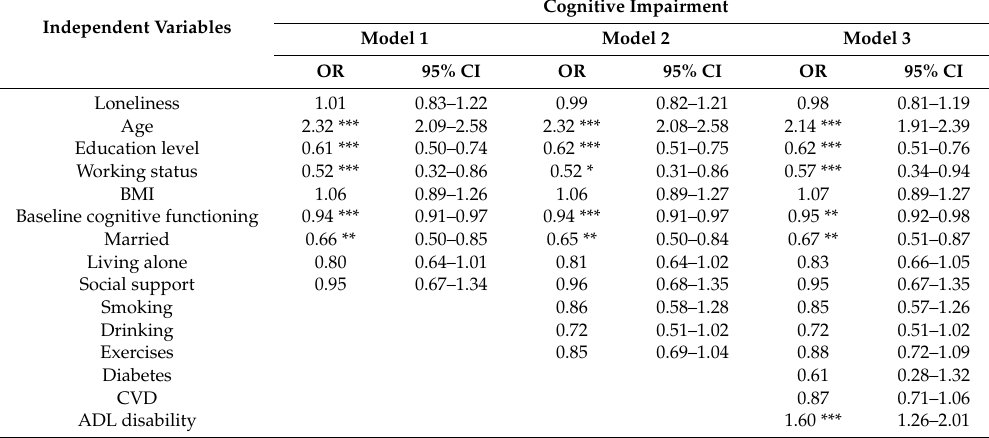
Table 3. Association between loneliness and cognitive impairment among women aged 65 or older. Independent